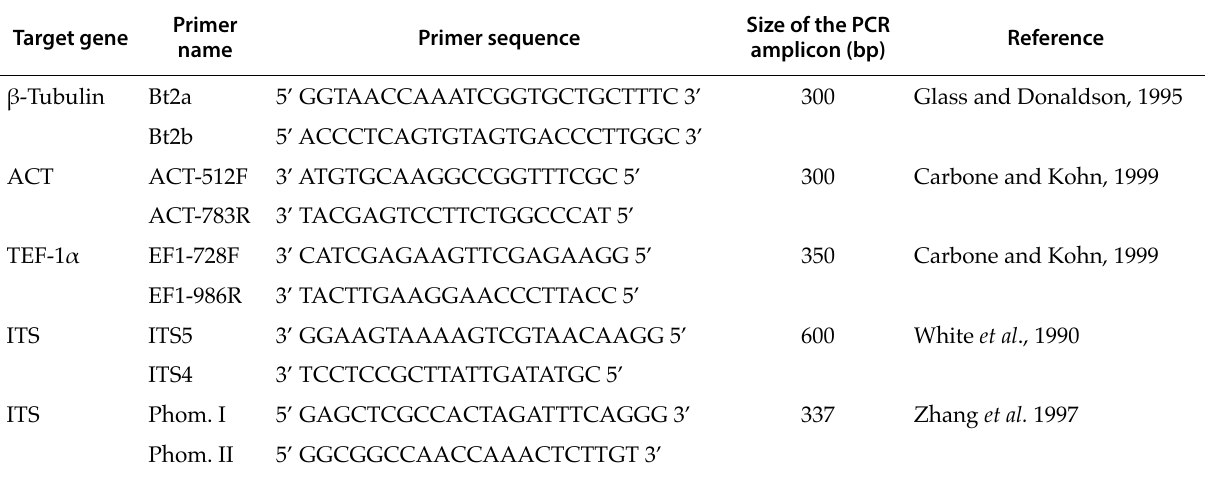
Table 1. Primer sets and corresponding amplification targets used for identification of fungi. Target